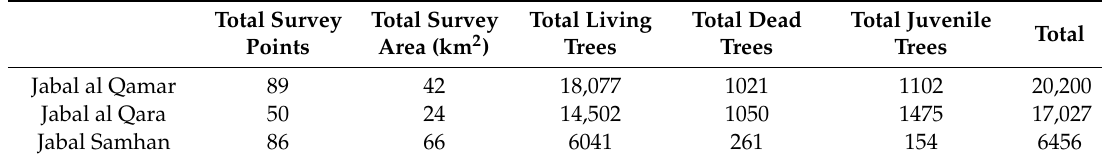
Table 1. Observation points and recorded